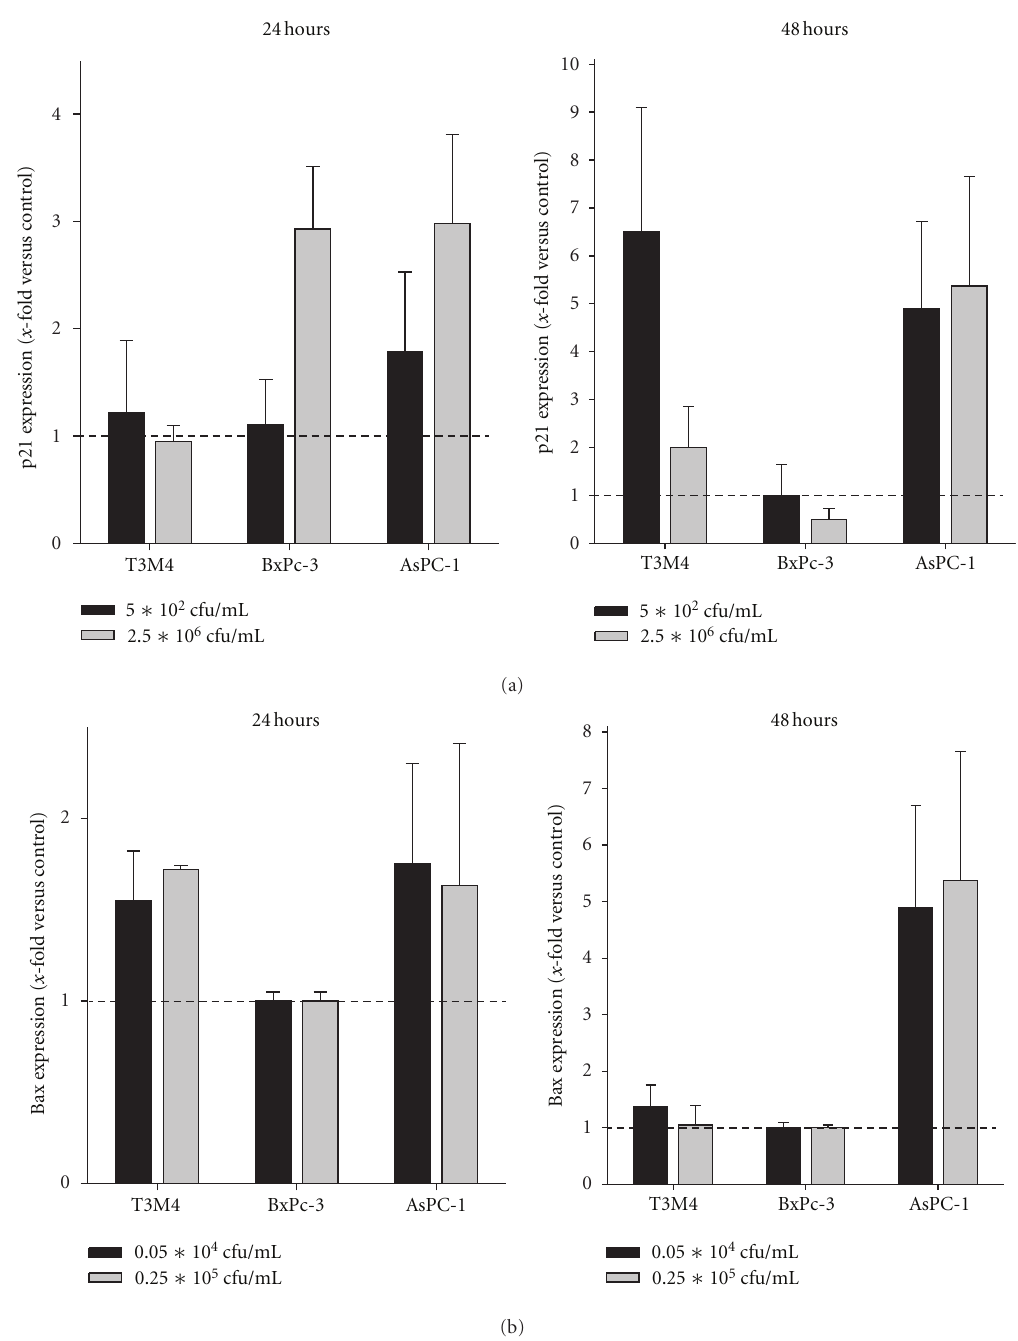
Figure 2: Gene expression analysis. mRNA expression of (a) p21 Waf and (b) Bax in tumor target cells following 24 and 48hours CT treatment. Quantitative real-time PCR was performed using predesigned TaqMan gene expression assays. Results show data of three separate experiments each performed in duplicates. Values are given as the mean ±